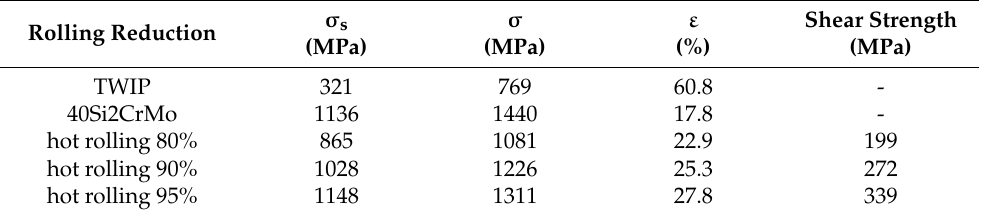
Figure 8. ( a ) Engineering stress-strain curve and ( b ) tensile-shear stress-displacement curves of multilayer TWIP/40Si2CrMo steels with different hot rolling reductions. Table 4. Mechanical properties of multilayer TWIP/40Si2CrMo steels with different hot rolling reductions.